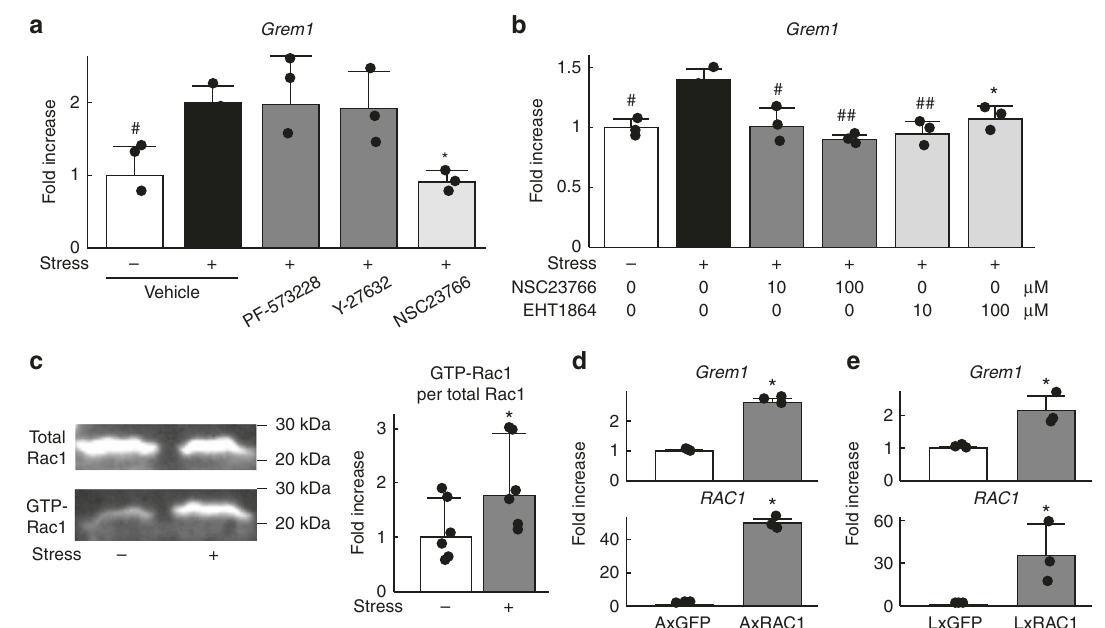
Fig. 7 Gremlin-1 induction by mechanical stress loading occurs through Rac1 activation. a Gremlin-1 mRNA levels in mouse primary chondrocytes treated with 10 µ M inhibitors of FAK (PF-573228), ROCK (Y-27632), or RAC1 (NSC23766) 24 h after cyclic tensile strain loading. n = 3 biologically independent samples. * P < 0.05, # P < 0.005 versus stress + , vehicle (one-way ANOVA test). b Gremlin-1 mRNA levels in mouse primary chondrocytes treated with Rac1 inhibitors NSC23766 or EHT1864 at 24 h after cyclic tensile strain loading. n = 3 biologically independent samples. * P < 0.05, # P < 0.005, ## P < 0.001 versus stress + , vehicle (one-way ANOVA test). c Rac1 pull-down activation assay using mouse primary chondrocytes with or without cyclic tensile strain loading. Quanti fi cation of densitometry data are shown below, and ratios of positive Rac1 per total Rac1 are shown as fold-increase in the right graph. n = 5 biologically independent samples. * P < 0.05 versus stress – (Student ’ s unpaired two-tailed t -test). d Gremlin-1 mRNA levels in mouse primary chondrocytes transduced with an adenoviral vector containing Rac1 or GFP . n = 3 biologically independent samples. * P < 0.05 versus GFP (Student ’ s unpaired two-tailed t -test). e Gremlin-1 mRNA levels in ATDC5 cells lentivirally overexpressing Rac1 or GFP . n = 3 biologically independent samples. * P < 0.05 versus